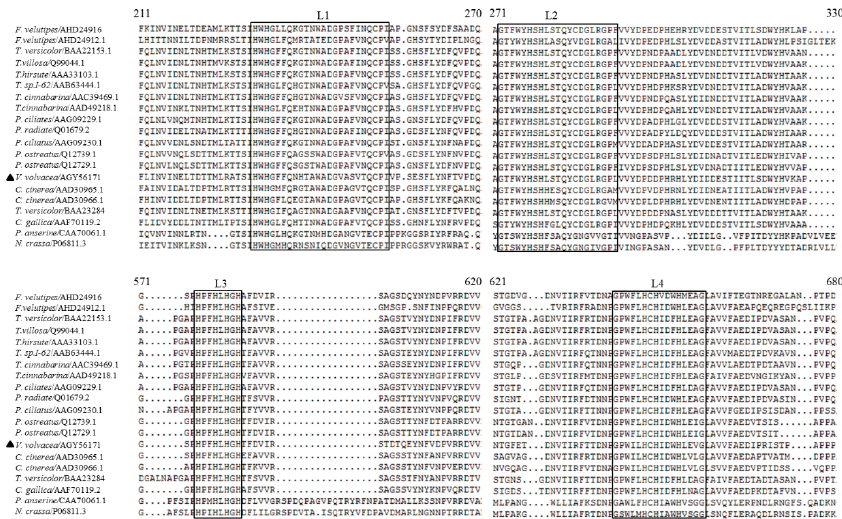
Figure 4. Alignment of the deduced amino acid sequence of VvLCC3 with homologous laccases using Clustal X (1.8). Four black boxes indicate four fungal laccase signature sequences (L1-L4), including 10 conserved histidine residues and one cysteine residue. The triangle indicates V. volvacea VvLCC3 protein.